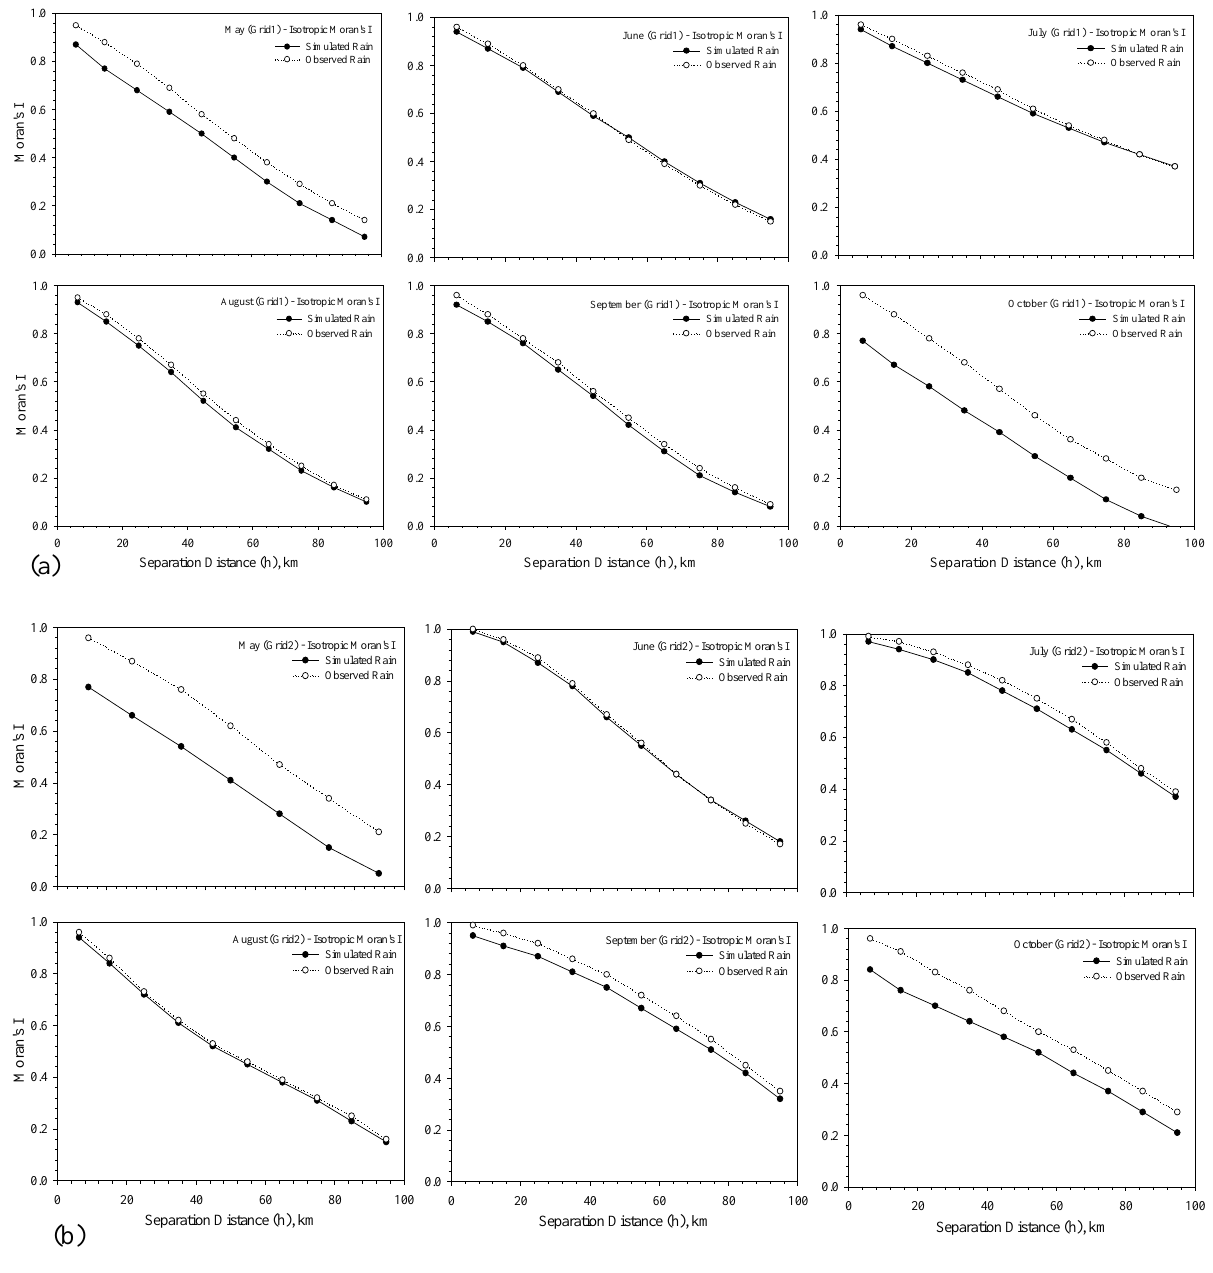
Fig. 11. Moran’s “ I ” isotropic autocorrelogram between ECHAM4 SRES A2 downscaled precipitation rain field and observed rain field for (a) grid 1-wet period, and (b) grid 2-wet period.